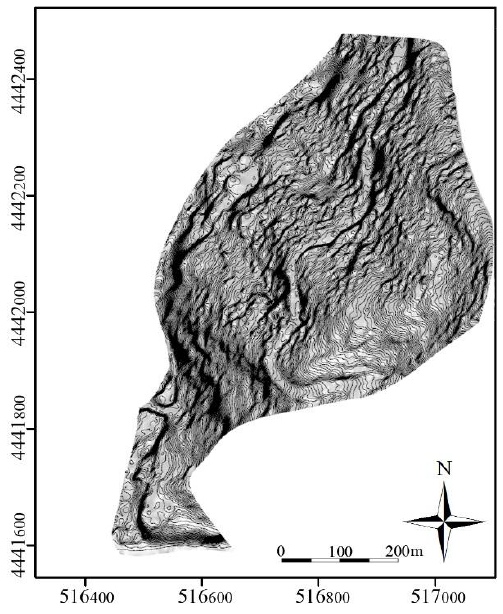
Figure 5. NURBS surface shown by contour lines.